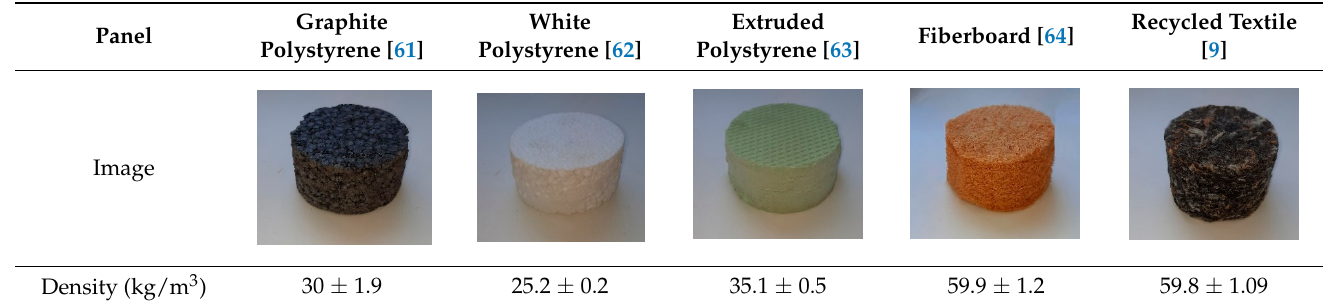
Table 3. Overview of parameters of tested commercially available insulating materials.